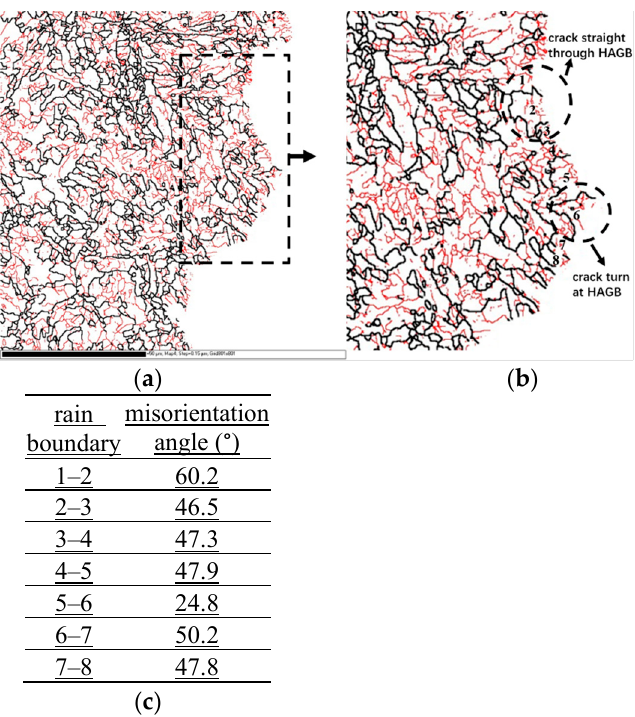
Figure 1. ( a ) Boundary distribution along the crack propagation path; ( b ) enlarged image of the dotted wire frame in Figure 1a; ( c ) misorientation angle between the grain boundaries.